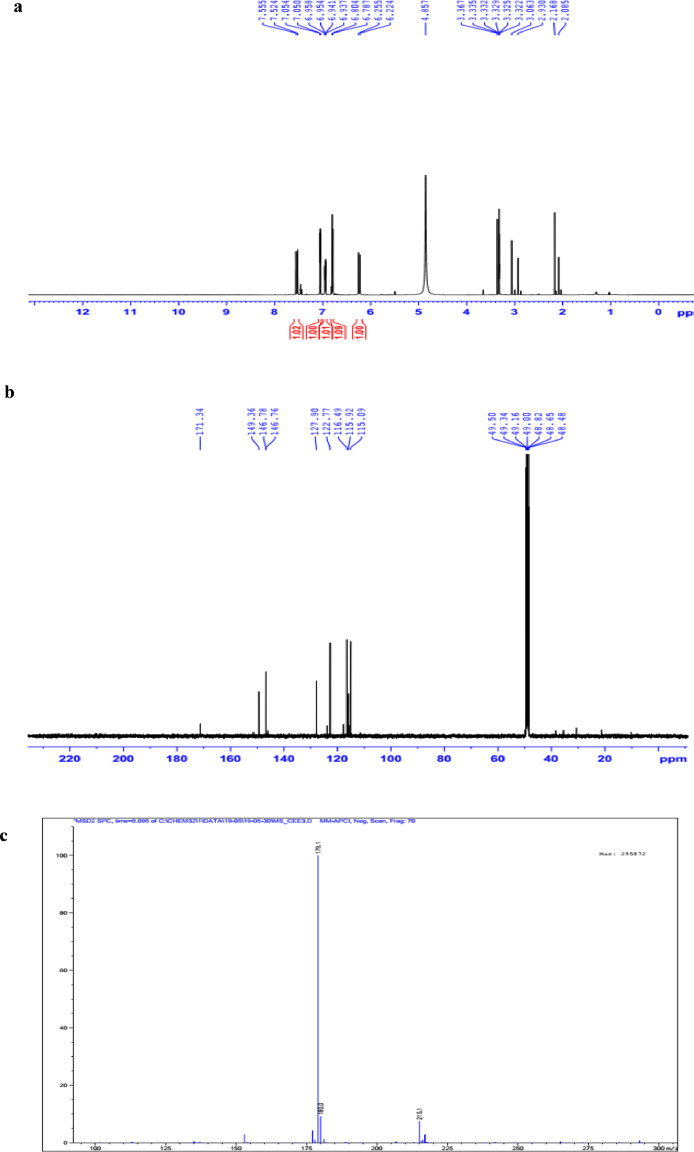
a. 1H NMR (500 MHz, CD3OD) of 5, b. 13C NMR (125 MHz, CD3OD) of 5, c. (-) APCI-MS of 5.